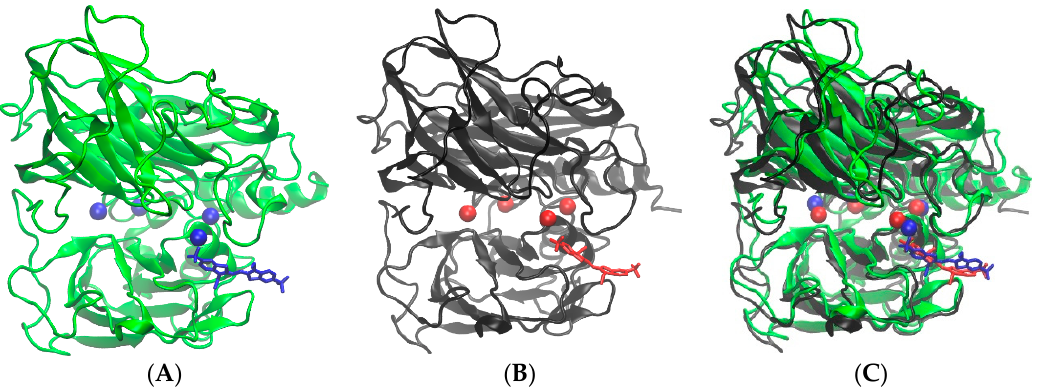
Figure 7. Superimposition of the most abundant protein and ligand conformations from each system. ( A ) In water. ( B ) In TMG-Ser. ( C ) Cluster ( B ) Superimposed on Cluster ( A ).